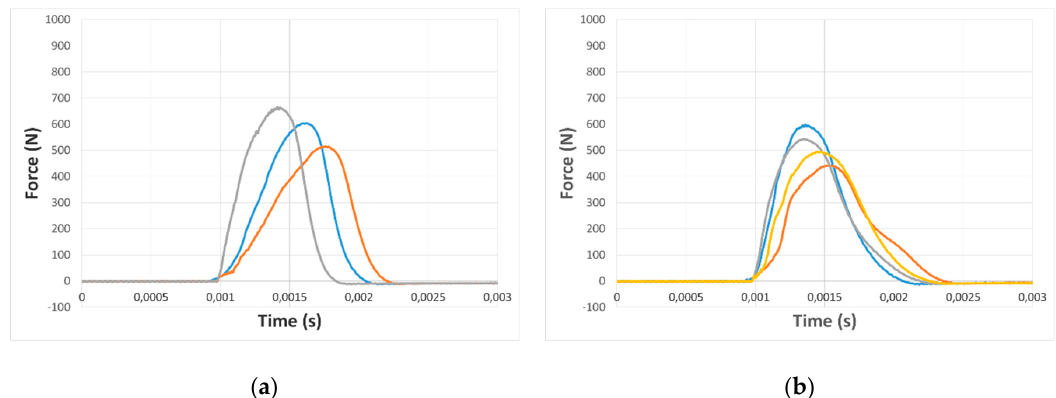
Appl. Sci. 2019 , 9 , x Table 2. Results of impact test on Blu room vault. Figure 9. Impact test on Pelagi room vault: force–time curve of ( a ) P13 test; ( b ) P5 test.